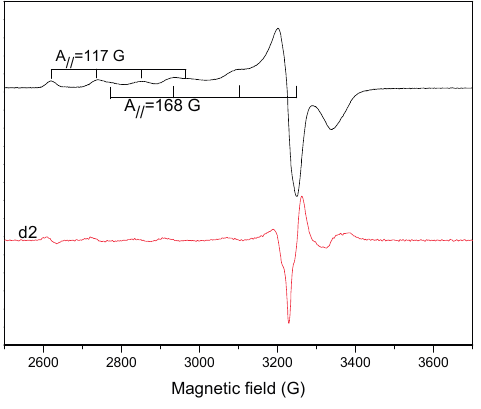
Figure 11. EPR spectrum of the complex 1 , in DMSO solution, registered at 77 K and (d2) second derivative spectra.